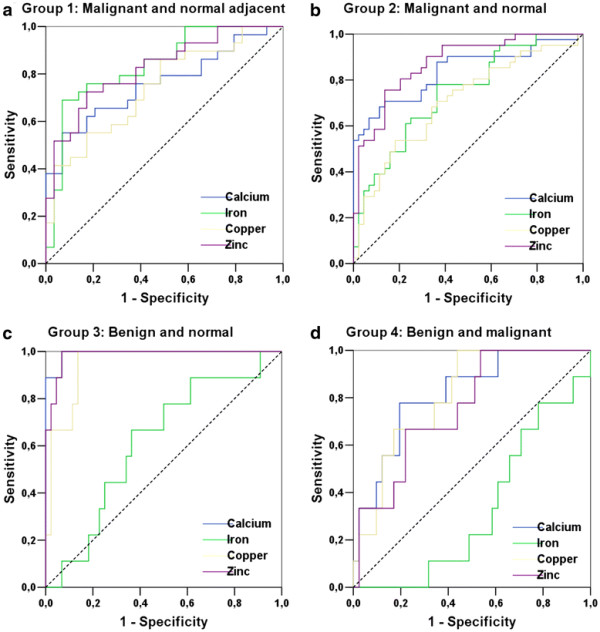
ROC curves obtained from the study of trace element concentration distributions. Group 1: malignant and normal adjacent, group 2: malignant and normal, group 3: benign and normal, group 4: benign and malignant. Reference lines are shown in dotted lines.